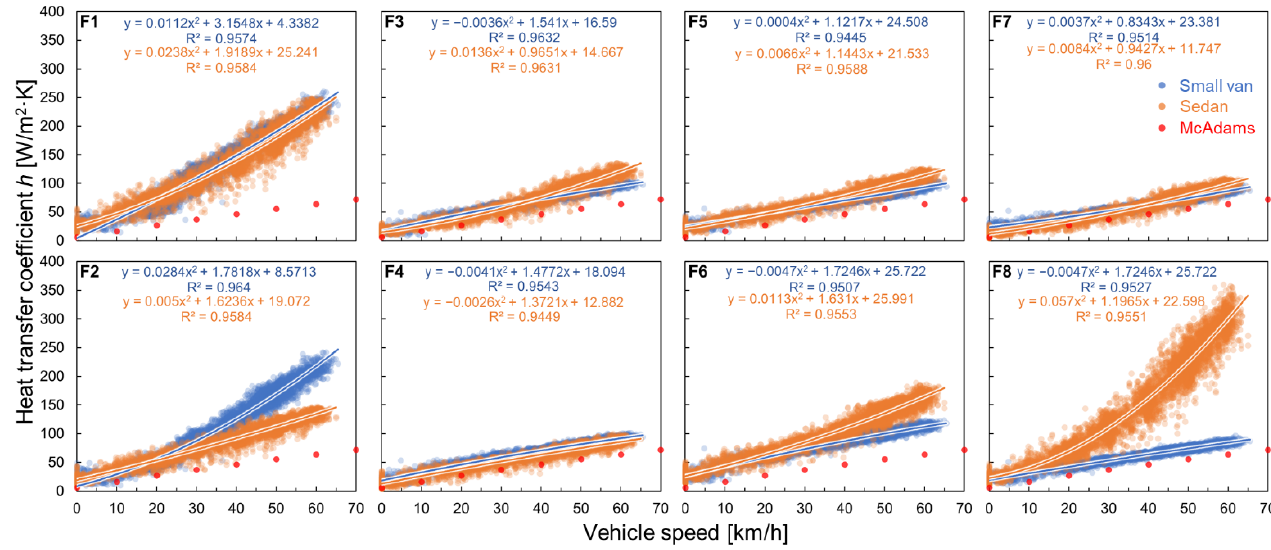
Figure 7. Convective heat transfer coefficient measurement at positions (F1–F8) in Figure 2: small van (blue), sedan (orange), and McAdams (red).